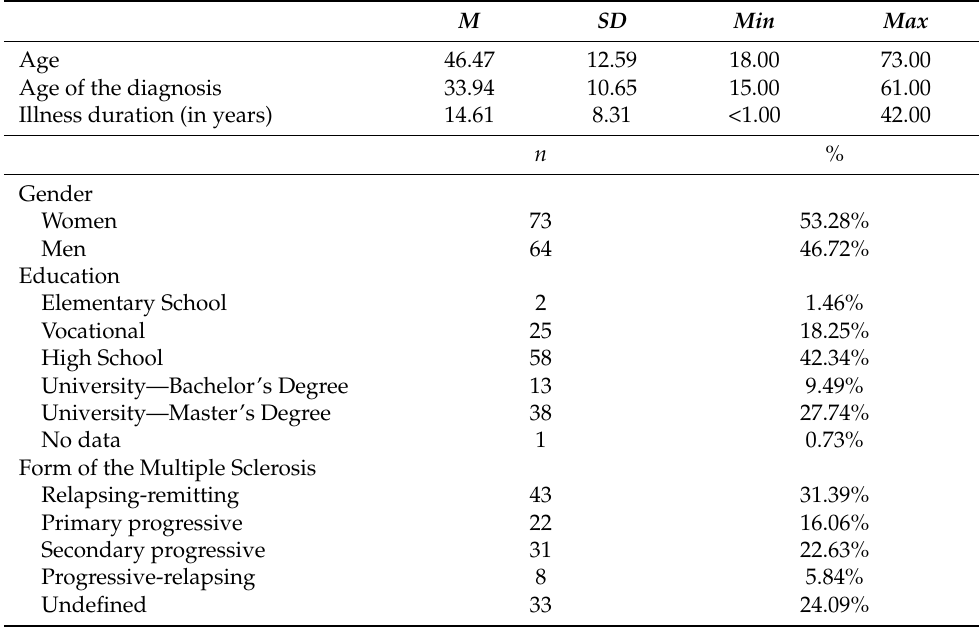
Table 1. Characteristics of the studied